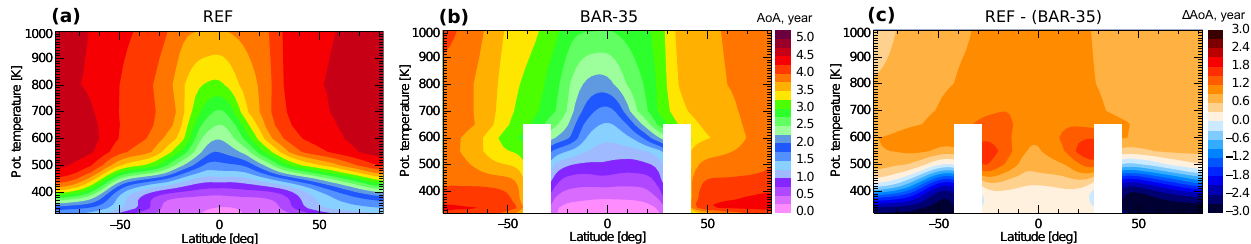
Figure 7. Zonal mean age of air distributions for 2011. Shown data are from the CLaMS reference simulation (a) and from the sensitivity simulation with barriers along latitude circles at 35 ◦ N/S (b) and the absolute difference between them (c) . Transport barriers are set between the Earth’s surface and the 600K potential temperature levels and are represented in white.